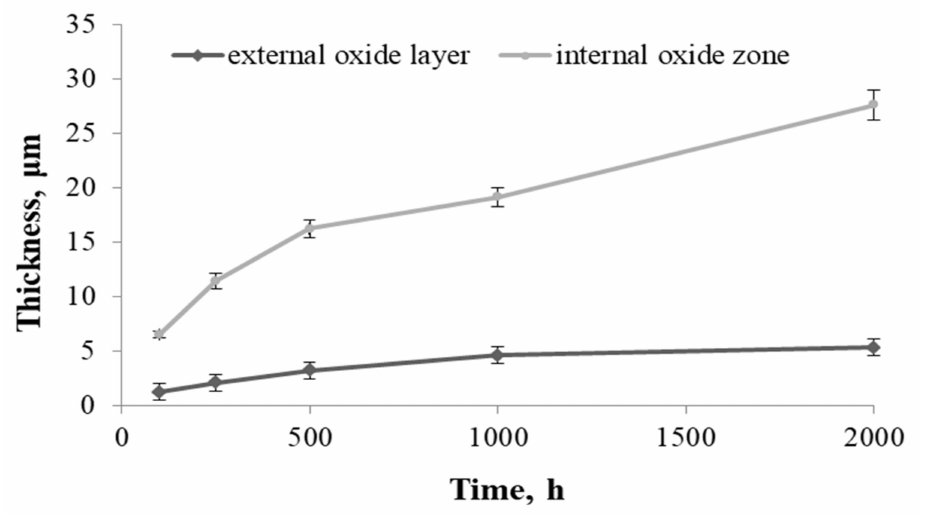
Figure 9. Change in the thickness of the external oxide layer and the internal oxidation zone during the oxidation of the Inconel 740H alloy and in steam at 750 ◦